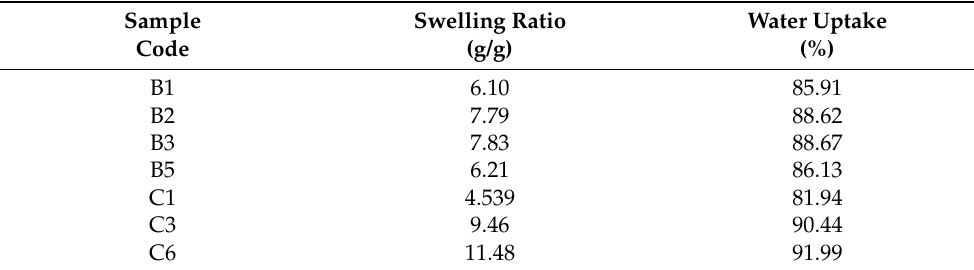
Table 2. Swelling properties of the different hydrogels sample obtained.